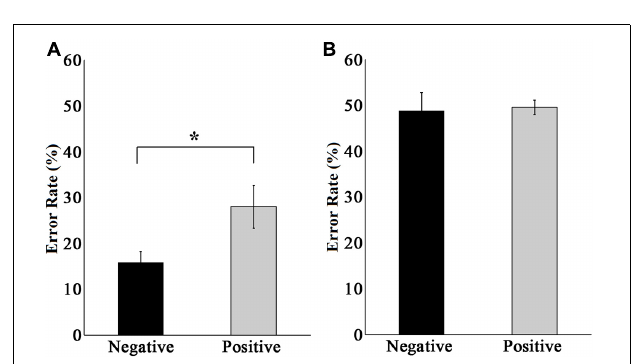
FIGURE 6 | Error rates in emotion discrimination tasks in the peripheral area in experiments 1 (A) and 2 (B) . The black bar represents the error rate of all subjects when discriminating negative faces. The gray bar represents the error rate of all subjects when discriminating positive faces. The error rate is the non-normalized data. ∗ p <